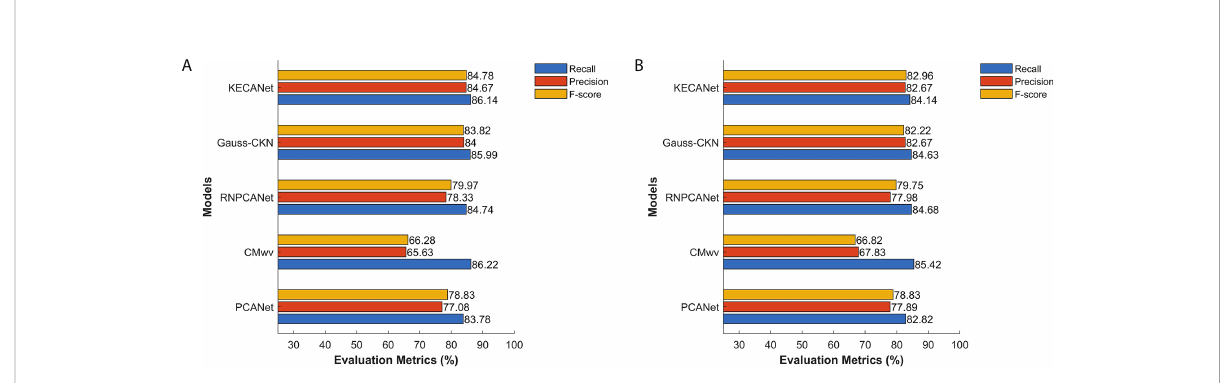
FIGURE 8 Average classi fi cation performance in WV1 (A) and WV2 (B) imagette classi fi cation of different methods.